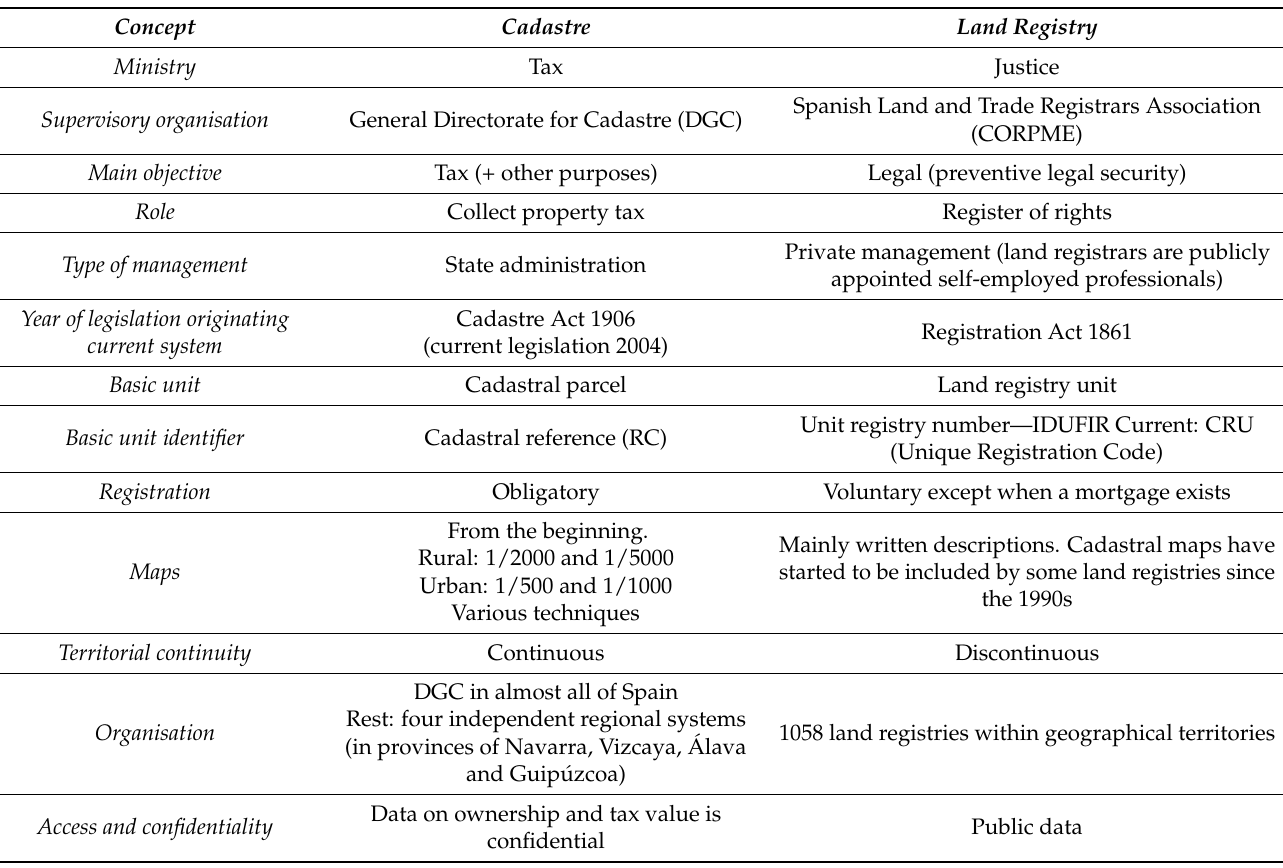
Table 1. Comparative scheme cadastre–land registry in Spain. Source: